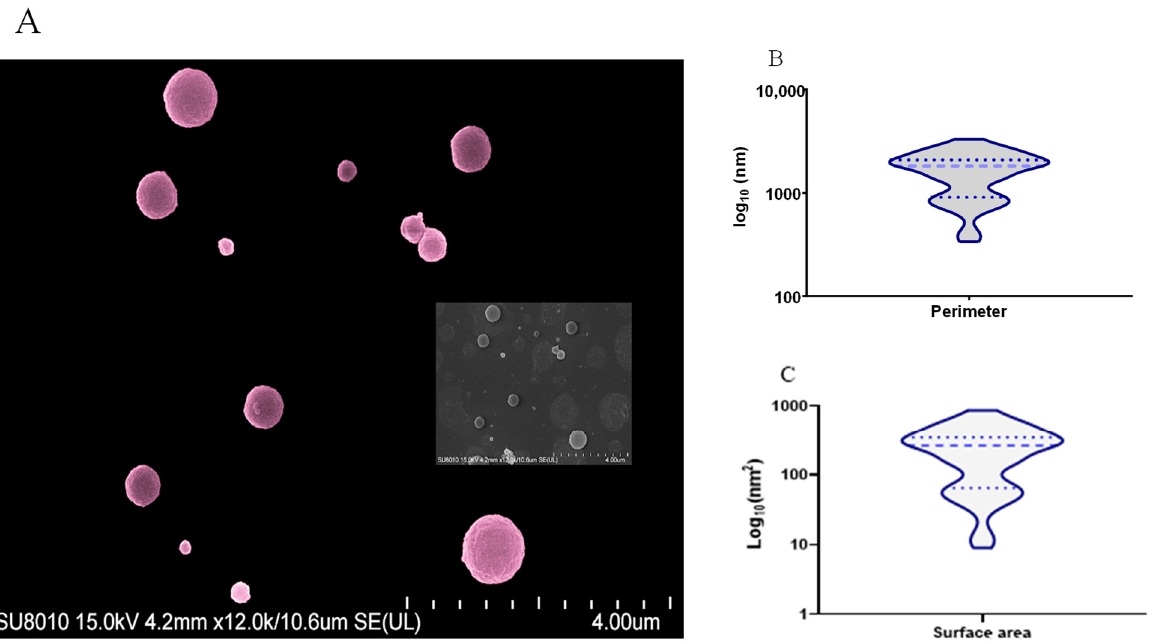
Figure 3. Topography and dimensions of T. b. brucei extracellular nanovesicles. TbEVs purified from culture-derived parasites were analyzed by SEM and images were acquired. A representative image of TbEVs ( A ) artificially coloured, using the GIMP2.10.0 software is shown. Perimeter ( B ) and surface area ( C ) of TbEVs estimated by Image J are represented by violin plots, indicating median (thick blue bars), interquartile range (blue dots) and distribution.